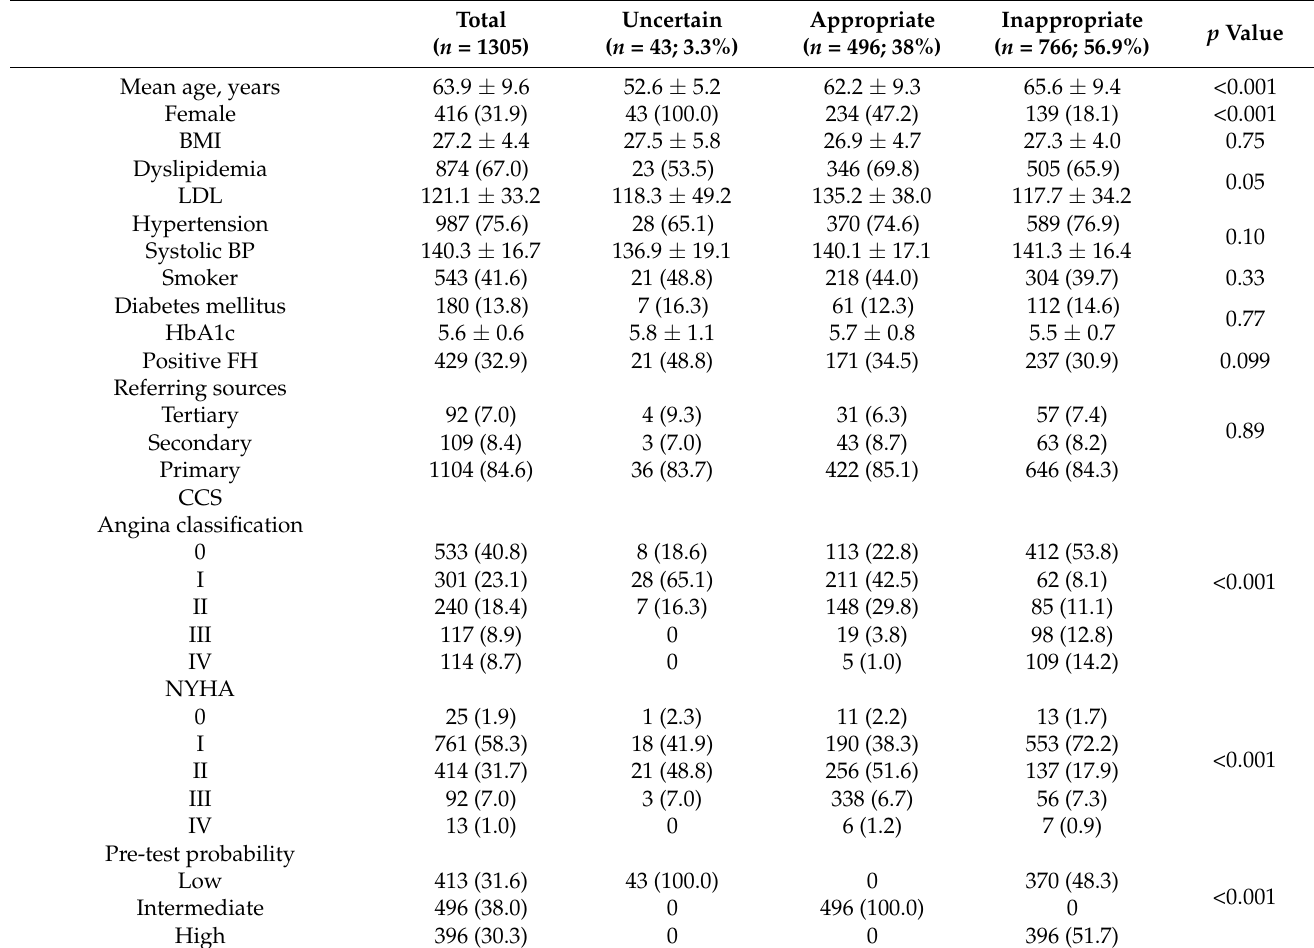
Table 1. Clinical characteristics and CAD pre-test probability